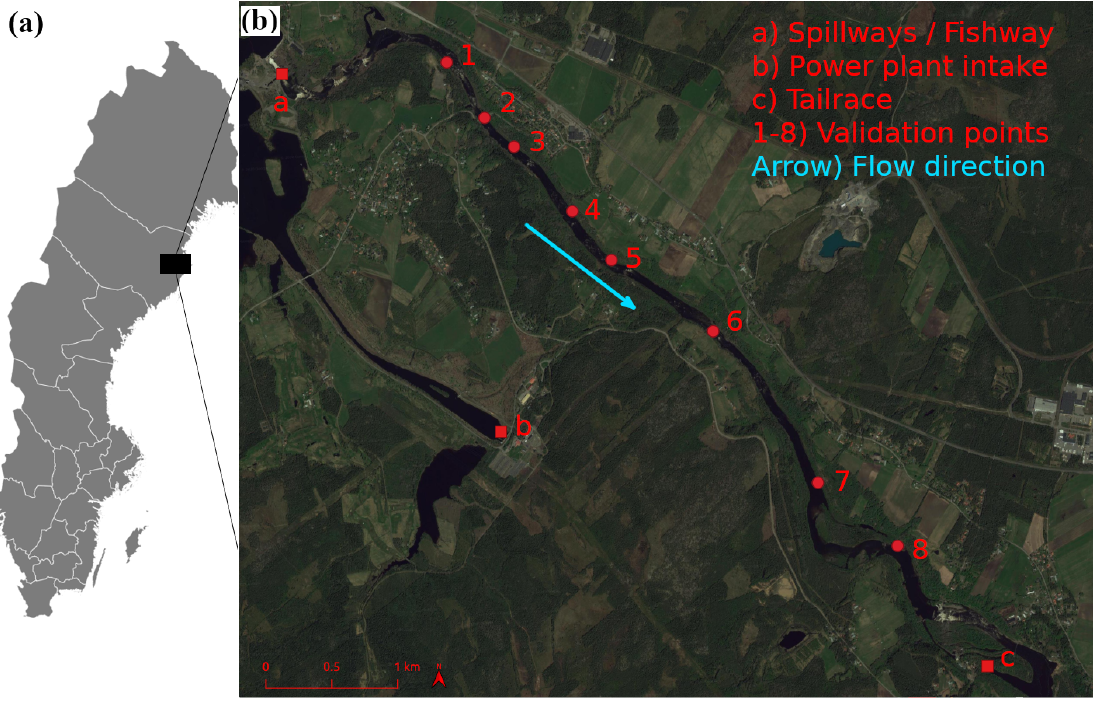
Figure 1. ( a ) Position of Stornorrfors in Sweden. ( b ) Key locations in the study reach and the extent of the numerical model.